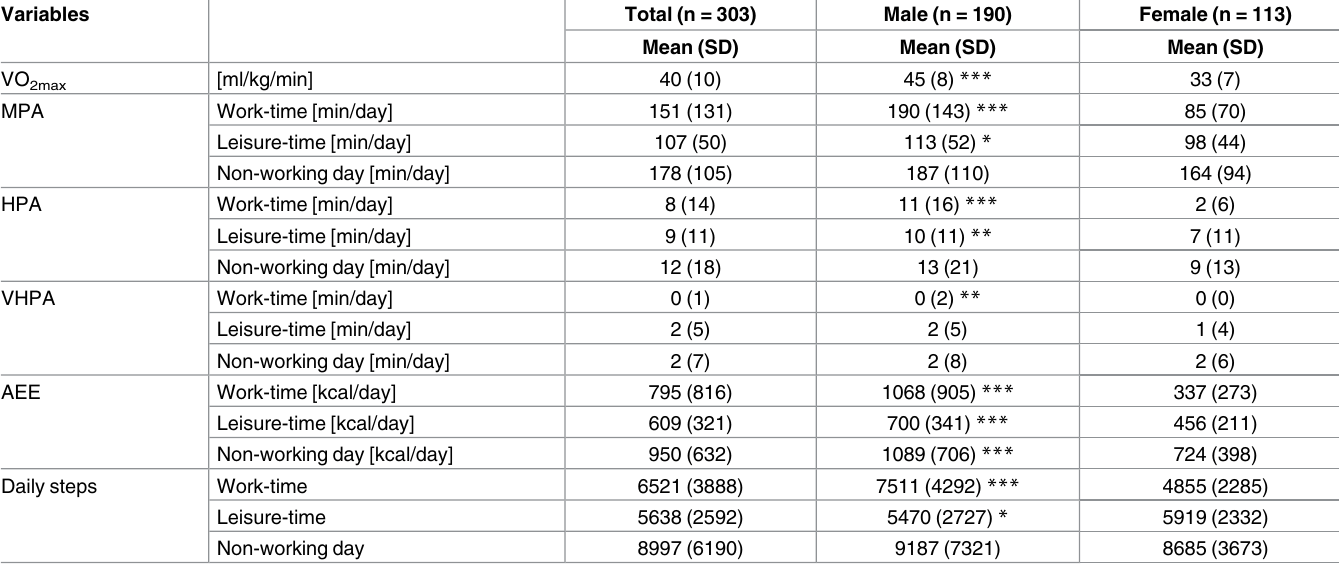
Table 3. Physical activity data, measuredwith objective methodology, SenseWearMini